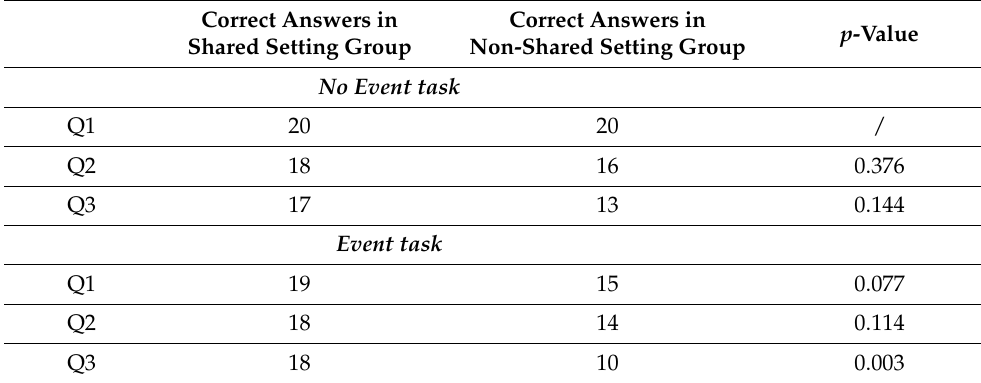
Table 2. Number of correct answers per question as measured with SAGAT for each setting. Correct Answers